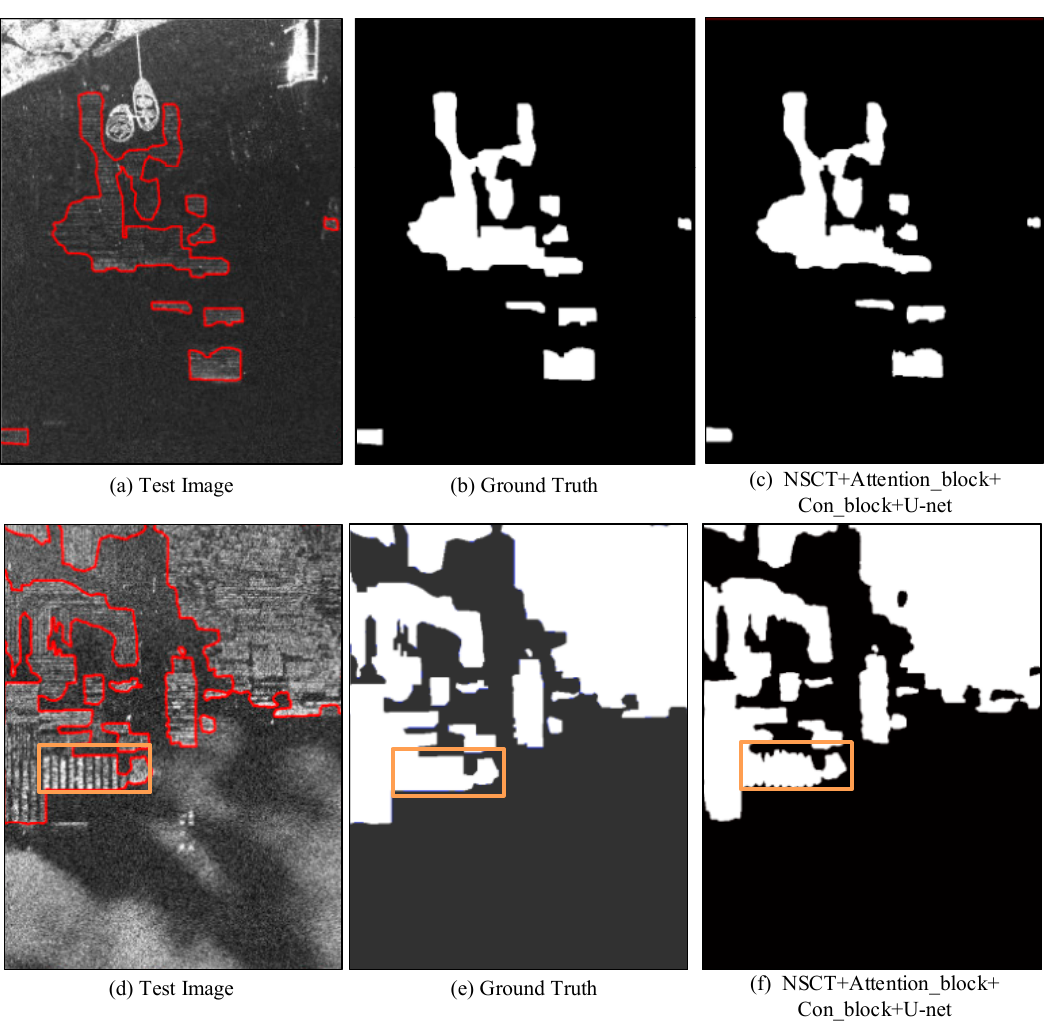
Figure 15. Results of the applied experiment for subsets of the study area. ( a , d ) Test image. ( b , e ) Ground truth. ( c , f ) The results obtained by the proposed method. Table 3. Precision, recall, F1, and IOU scores on the demonstration areas of the applied experiment.